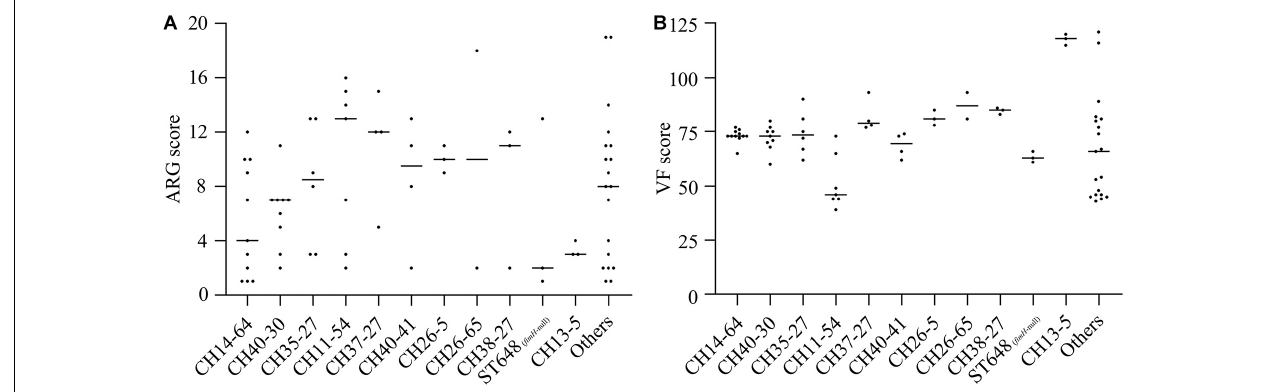
FIGURE 2 | ARG (A) and VF (B) scores according to CH or ST types among the 74 ExPEC isolates. ARG and VF scores were defined as the number of unique ARG and VF detected for each isolate, respectively. ARG scores in CH37-27 isolates were significantly higher than in CH14-64 or CH13-5 isolates while ARG scores in CH26-5 isolates were significantly higher than in CH40-30 or CH13-5 isolates ( P < 0.05). VF scores in CH13-5 isolates were significantly higher than in any of these 12 groups (except CH26-65) while VF scores in CH11-54 isolates were significantly lower than in any of these 12 groups (except ST648 and Others) ( P <